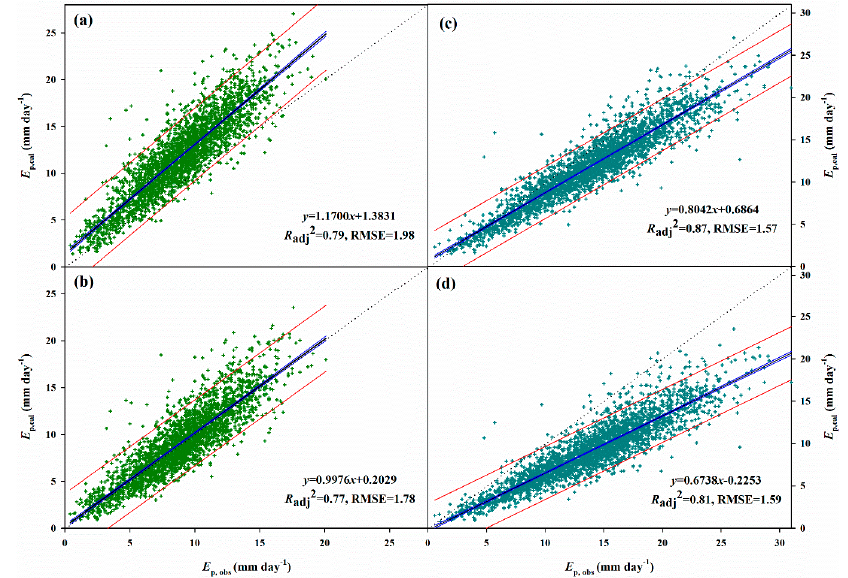
Figure 3. Relationship between daily observed pan evaporation ( E p,obs ) by the E601 ( a , b ) and φ 20 ( c , d ) and calculated pan evaporation by the original ( a , c ) and modified ( b , d ) PenPan model ( E p,cal ) for Ejin station during the unfrozen period from 1986 to 2001. The linear fitting, 95% confidence band, prediction band line, and value of regression analysis are shown. Water 2017 , 9 , 952